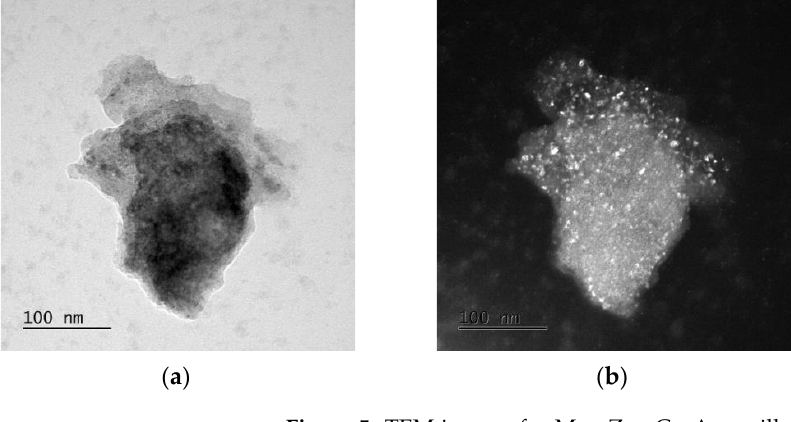
Figure 5. TEM images for Mg 65 Zn 30 Ca 4 Ag 1 milled for 50 h. ( a ) Bright field image, ( b ) dark field image, ( c ) SAED pattern from tested